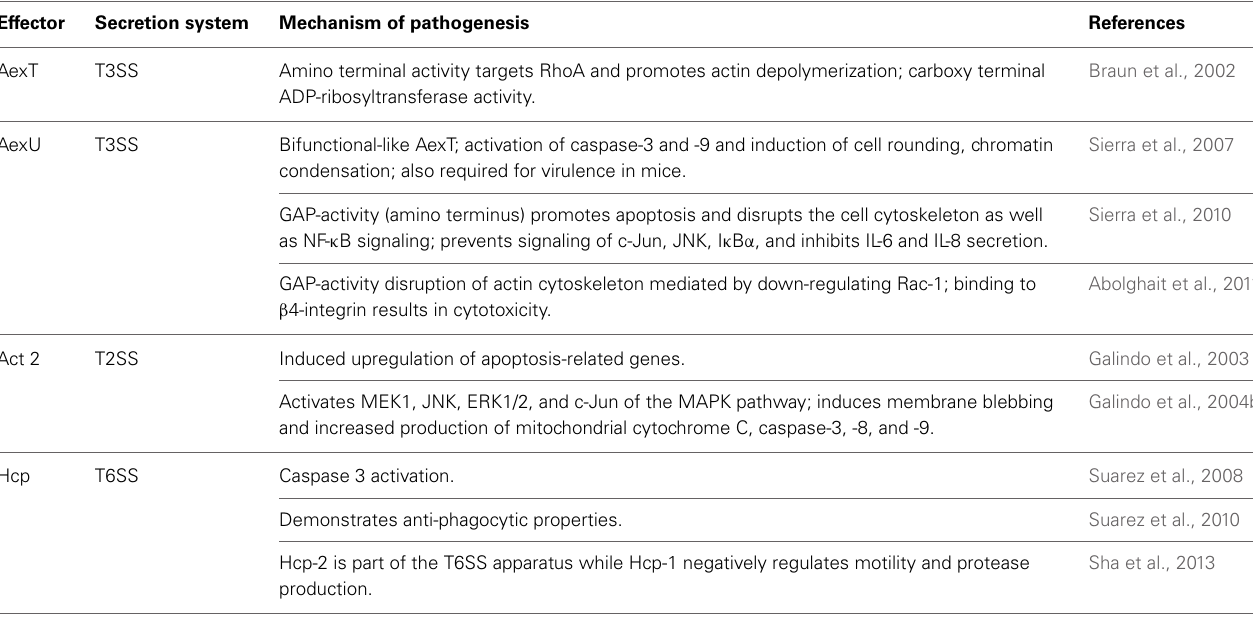
Table 2 | Aeromonad effector proteins AexT, AexU, Act, and Hcp mechanisms of action.